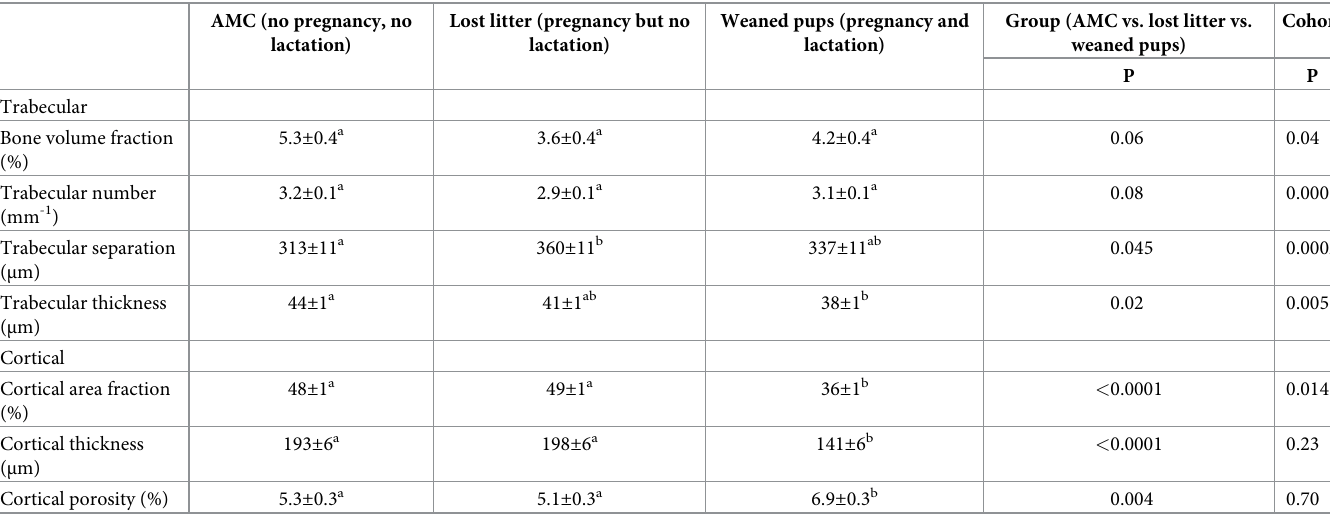
Table 5. Effects of pregnancy vs. lactation on skeletal traits. AMC (no pregnancy, no